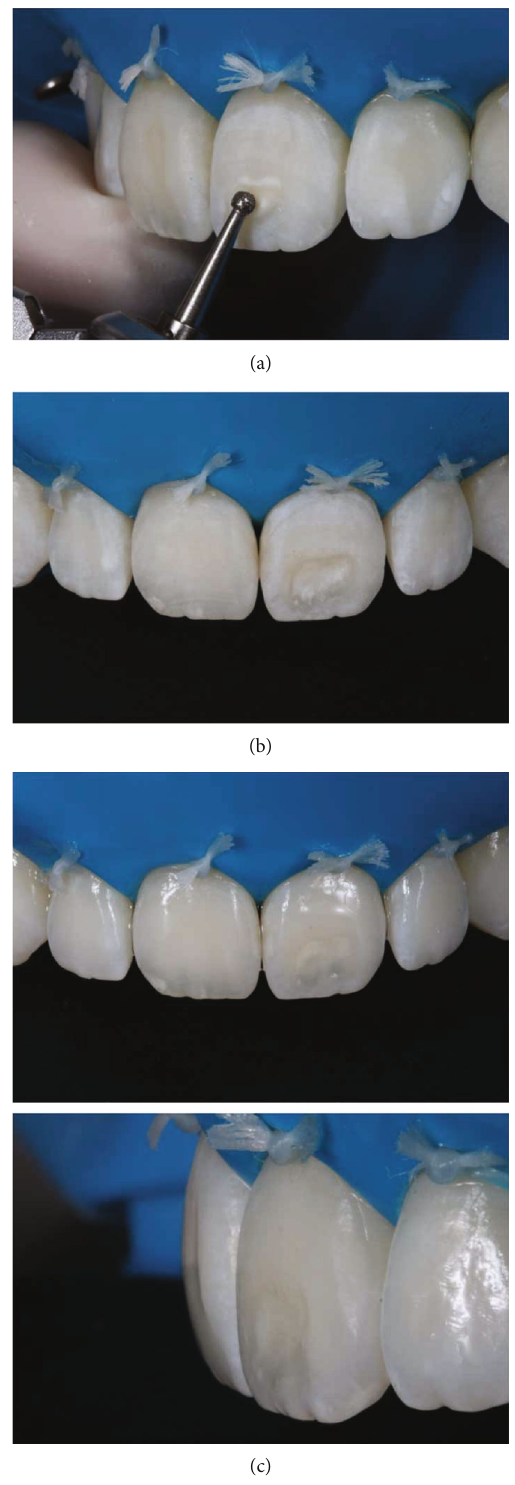
Figure 4: Absolute isolation was done with a rubber dam. The defect was removed with a spherical diamond tip. Lateral view of the central incisor after removal of the hypoplastic stain.